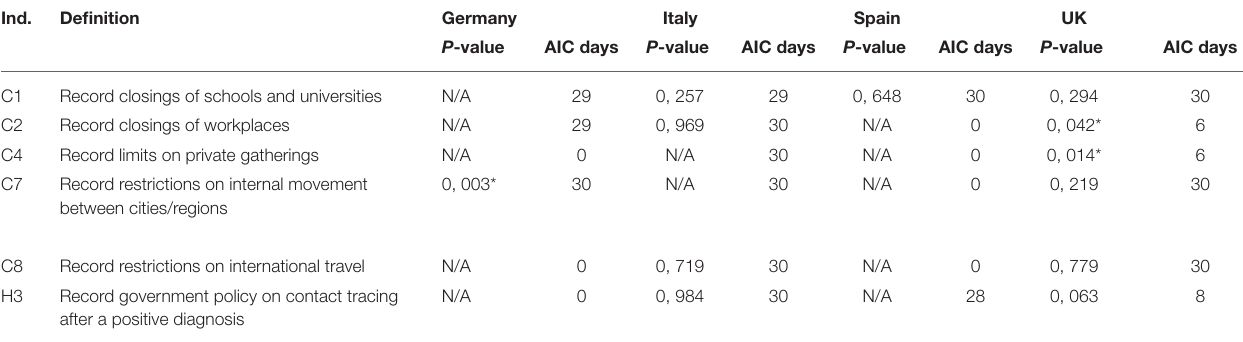
TABLE 2 | Results of the granger causality test and AIC days for four European countries (from 01/10/2020 to 10/01/2021).